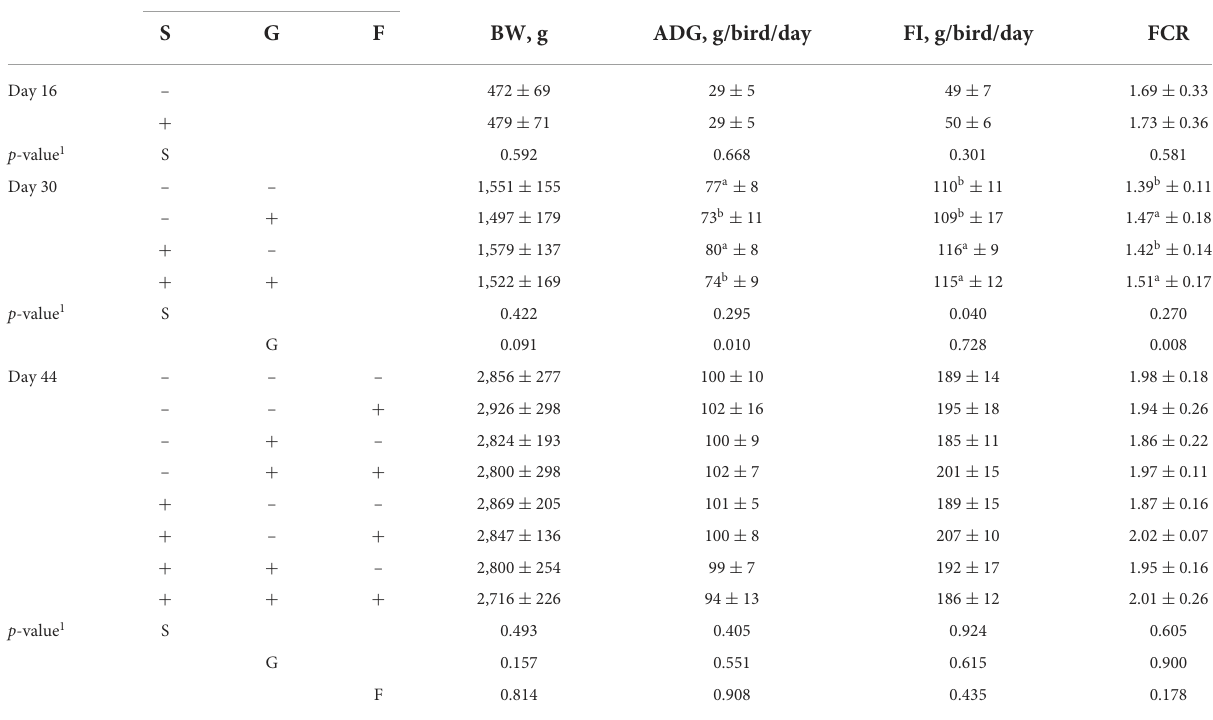
TABLE 1 The effect of chestnut tannins ( + : 2,000 mg/kg; –: 0 mg/kg) at different phases of rearing on mean body weight of broiler chickens at day 16, 30, and 44 of age and average daily gain, average feed intake and feed conversion ratio during the starter period (S, day 0–16), grower period (G, day 17–30), and finisher period (F, day